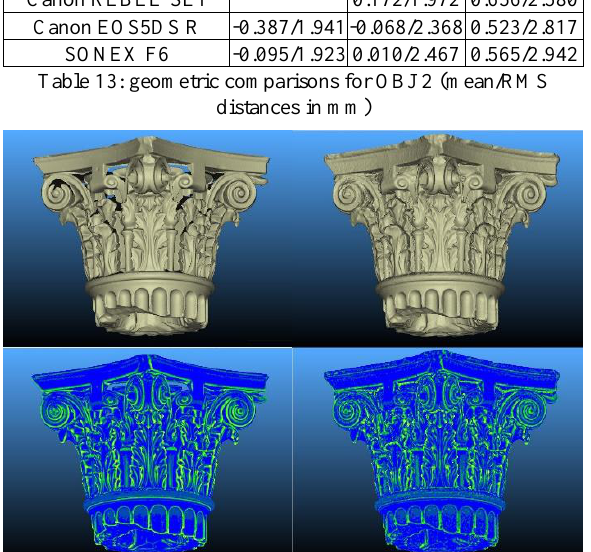
Figure 8: reference models for OBJ 2, meshes (up), roughness index maps (down), SF6 (left), 5DS R VIS (right)